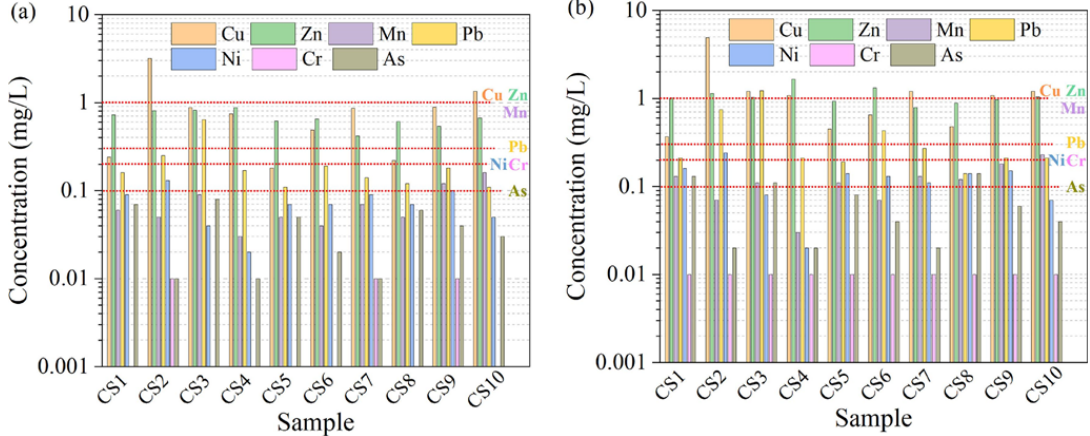
Figure 17. The concentrations of heavy metals leaching from the mortars mixed with ( a ) 30 wt.% and ( b ) 50 wt.% of CS. The red dashed lines are regulated leaching limits [27].